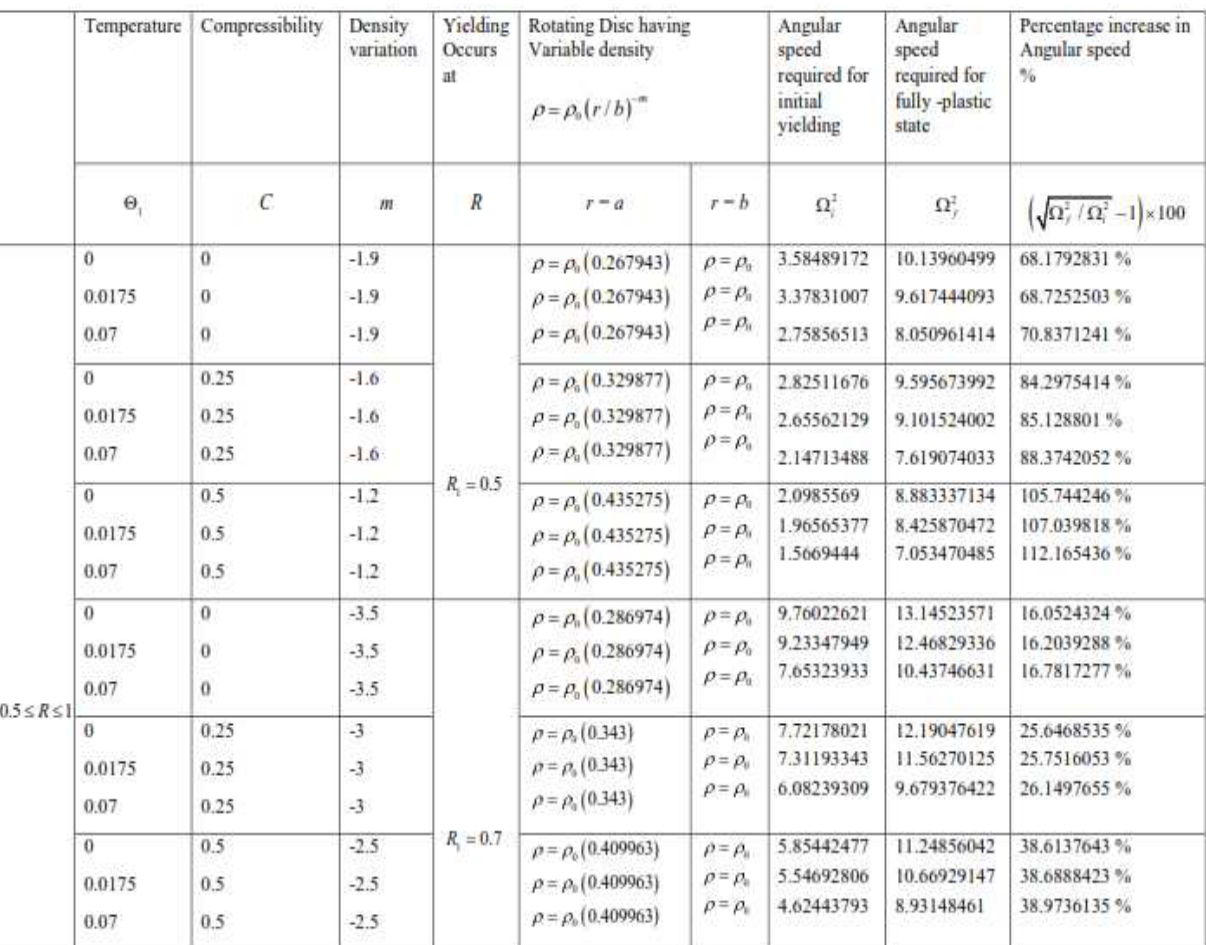
W W and fully plastic state 2 f i Q 1